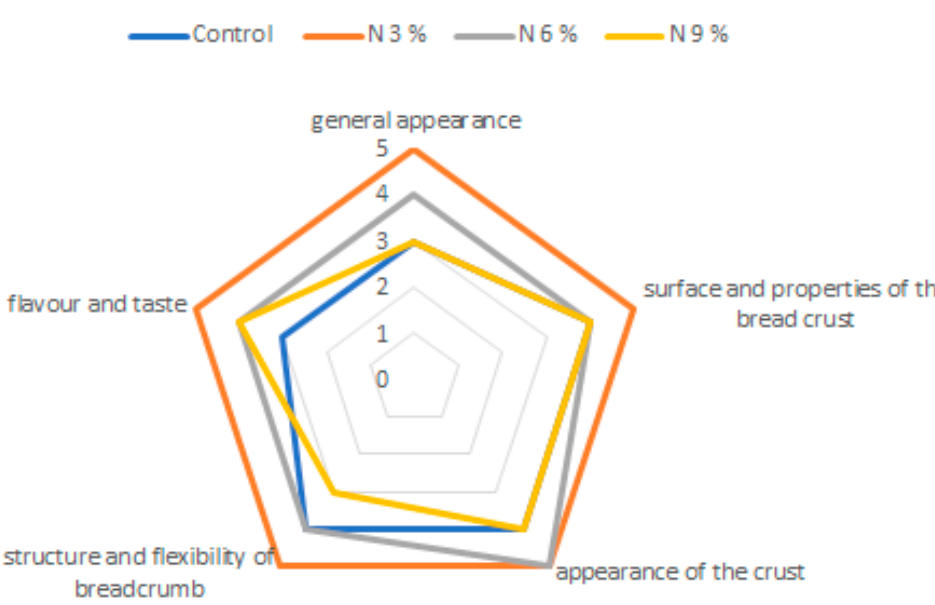
Figure 2. Results of sensory evaluation of breads with addition of Norik black oat wholemeal flour (sum of all panellists). C—control bread; H3—bread with 3% Hucul addition; H6—bread with 6% Hucul addition; H9—bread with 9% Hucul addition; N3—bread with 3% Norik addition; N6—bread with 6% Norik addition; n.d.—not detected; N9—bread with 9% Norik